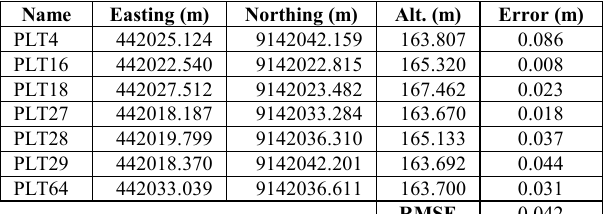
Table 2. Residual table for the check points for the registered and georeferenced TLS data.